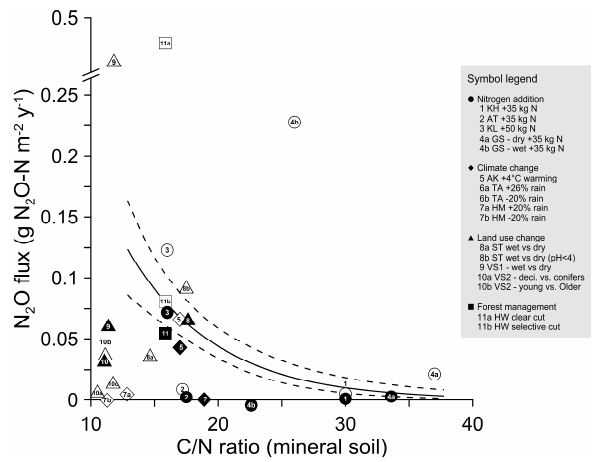
Fig. 4. N 2 O emission versus mineral soil C/N ratio (0–20cm) for control (filled symbols) and treatments (open symbols). Numbers in the symbols refer to sites and letters to treatments within site. Lines show the relationship (and its 95% confidence interval) found by Pi- legaard et al. (2006). The types of forest change treatments are rep- resented by different symbol shapes (circle: N addition; diamond: climate change; triangle: land-use change; square: forest manage- ment).